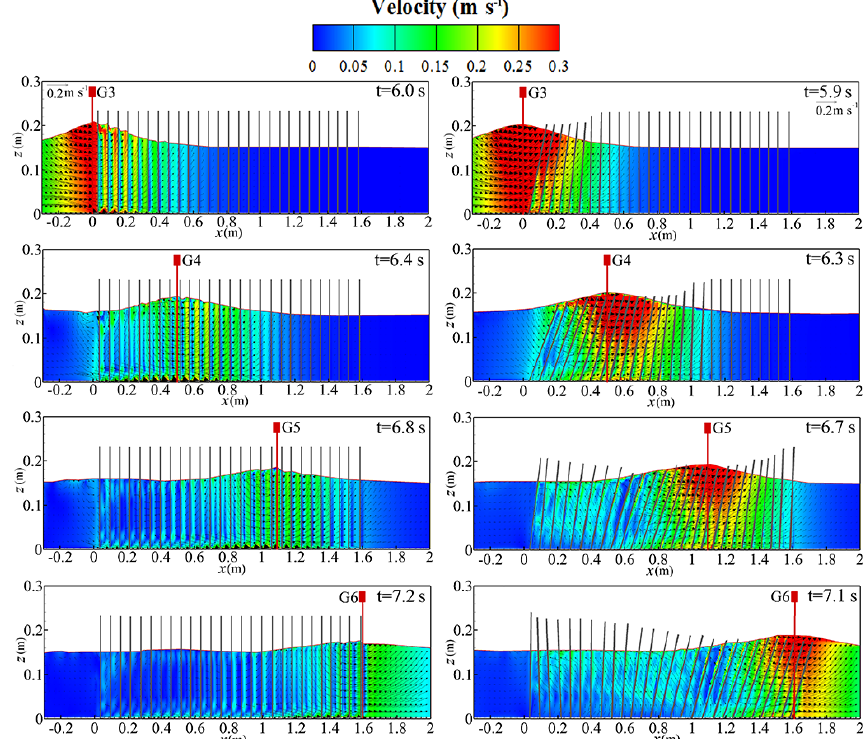
Figure 9. The snapshots of the velocity distribution for stationary cylinders (left) and moving cylinders (right), H i = 0.05m.